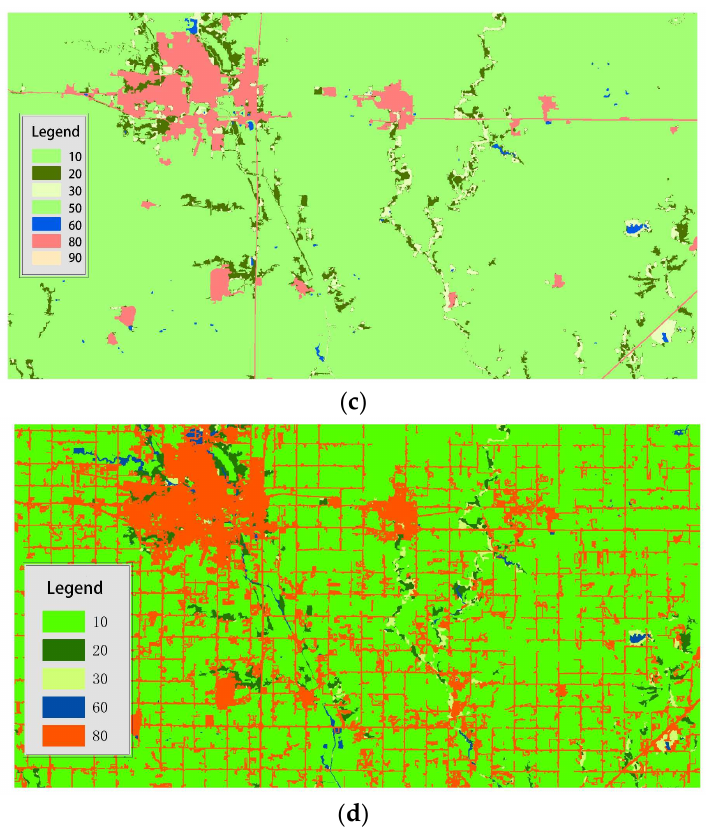
Figure 4. Classification products of the Soil Moisture Experiment 2002 (SMEX02) near Des Moines, Iowa, United States: ( a ) MCD12Q1_IGBP; ( b ) GlobeLand30 in 2000; ( c ) GlobeLand30 in 2010; ( d )